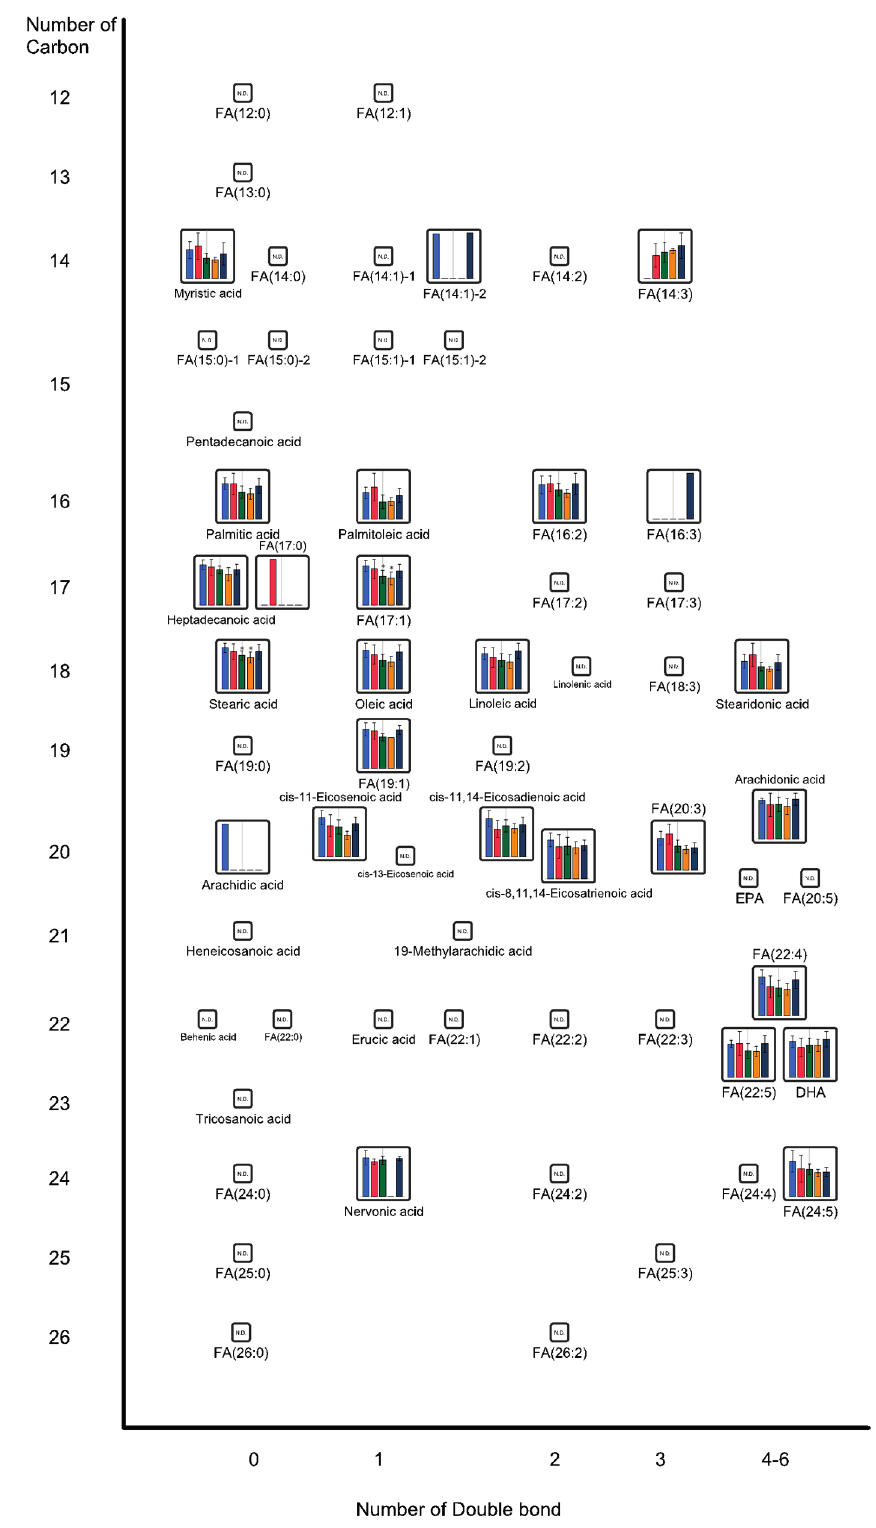
Figure 4. Plasma fatty acid (FA) levels. Each bar represents median ± standard deviation (SD) of metabolite in each group. * p < 0.05, ** p < 0.01 indicate significant differences in metabolite concentrations compared to the control group. All the p -values were determined using Welch’s t -test. (blue, the control; red, chitin nanofibers (CNFs); green, surface-deacetylated (SDA) CNFs; orange, chitin; navy, cellulose nanofiber (CLNF); N.D., not